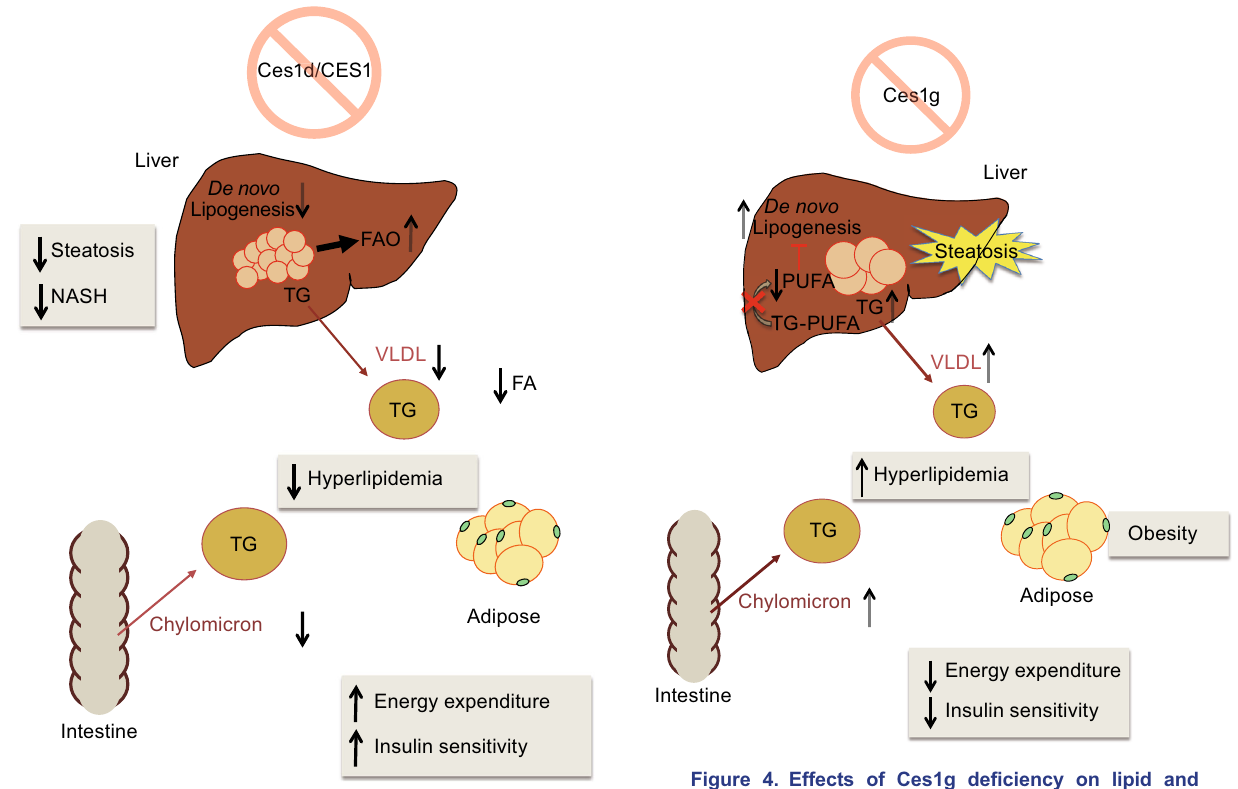
Figure 3. Effects of Ces1d de fi ciency on lipid and energy homeostasis.